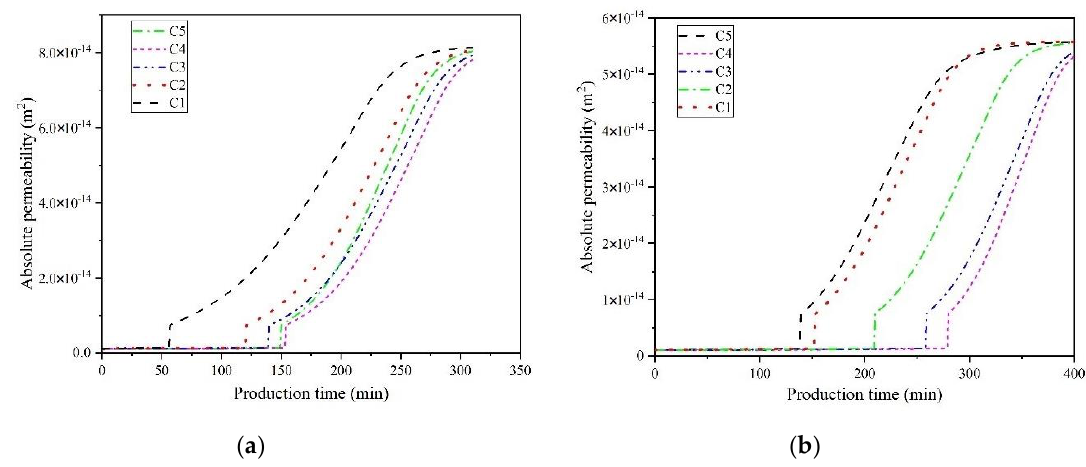
Figure 10. Absolute permeability variation with production time for mechanical ( a ) uncoupled and ( b ) coupled models.